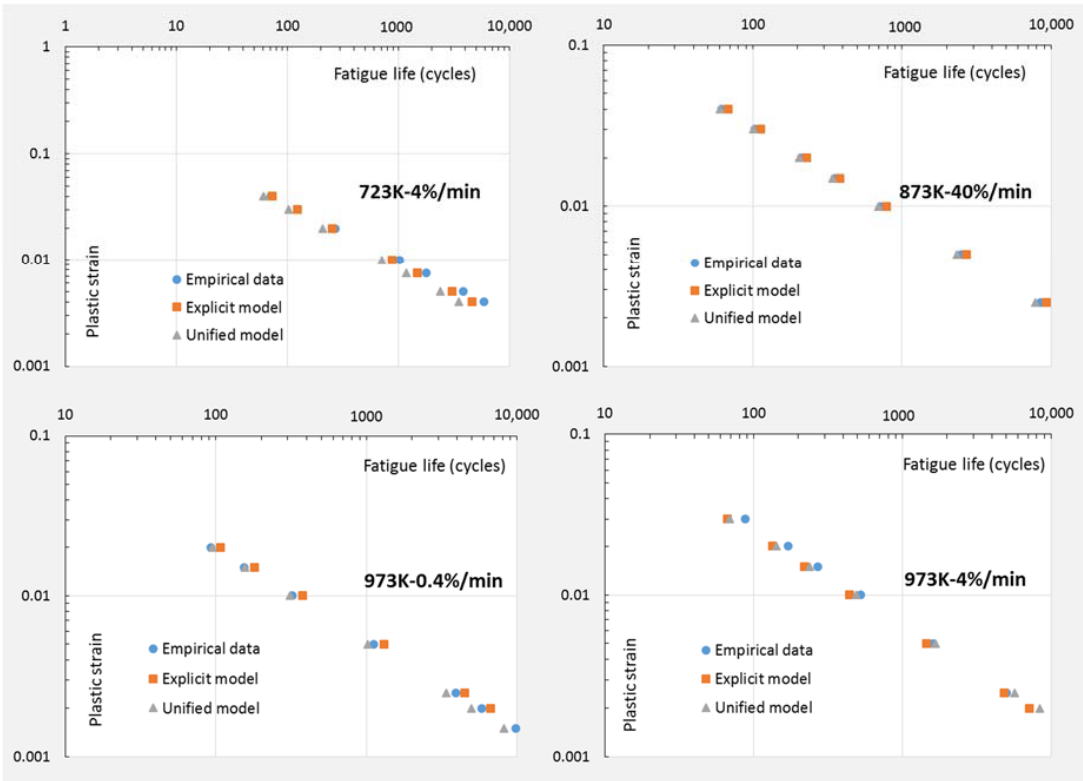
Figure 7. Empirical data and predicted life for Stainless steel 316. Table 7. The average errors and prediction ratios given by the unified model and the explicit model.